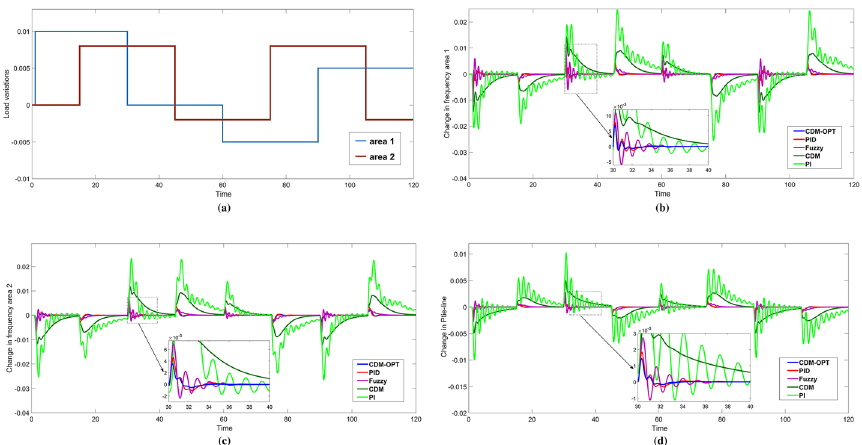
Fig. 8 Case 5 Signals: a load variations. b Frequency in area 1. c Frequency in area 2. d Tie-line between areas